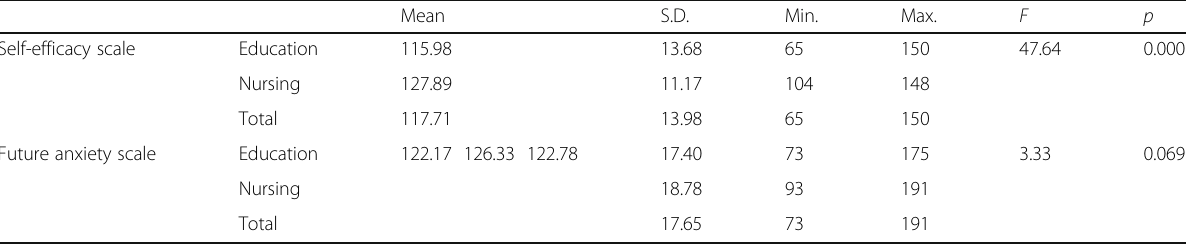
Table 5 Comparing college type as regards both future anxiety and self-efficacy Mean S.D. Min. Max. F